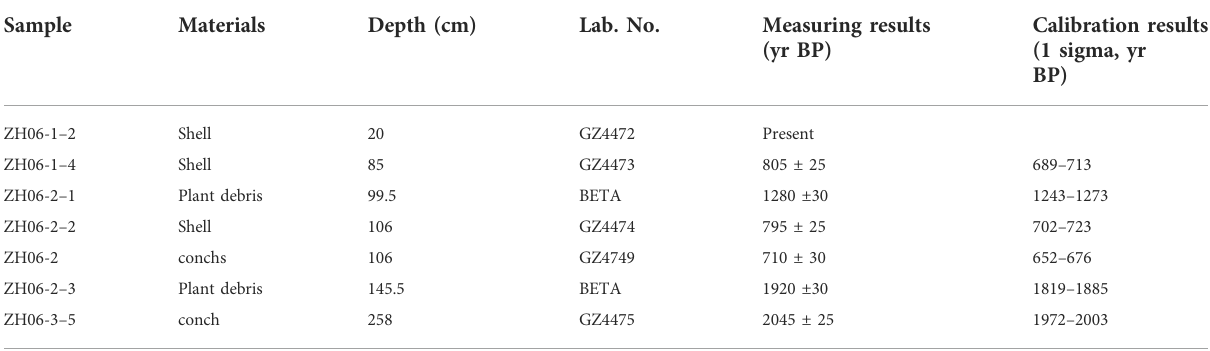
TABLE 1 The age-depth relation of Core